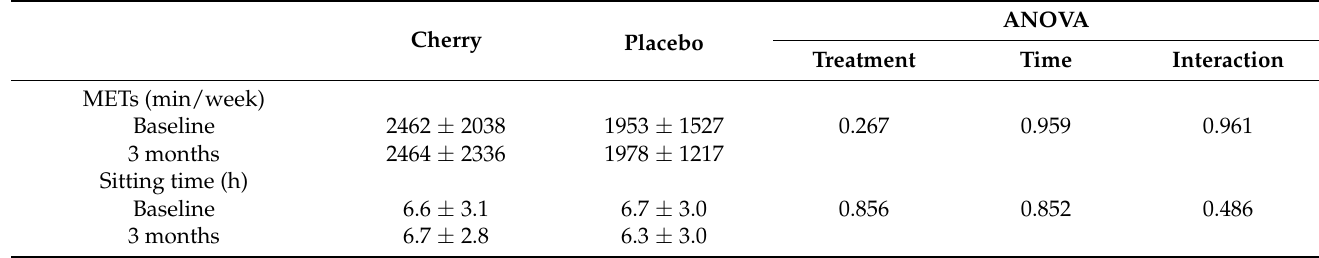
Table 2. Physical activity, diet, and body composition during the